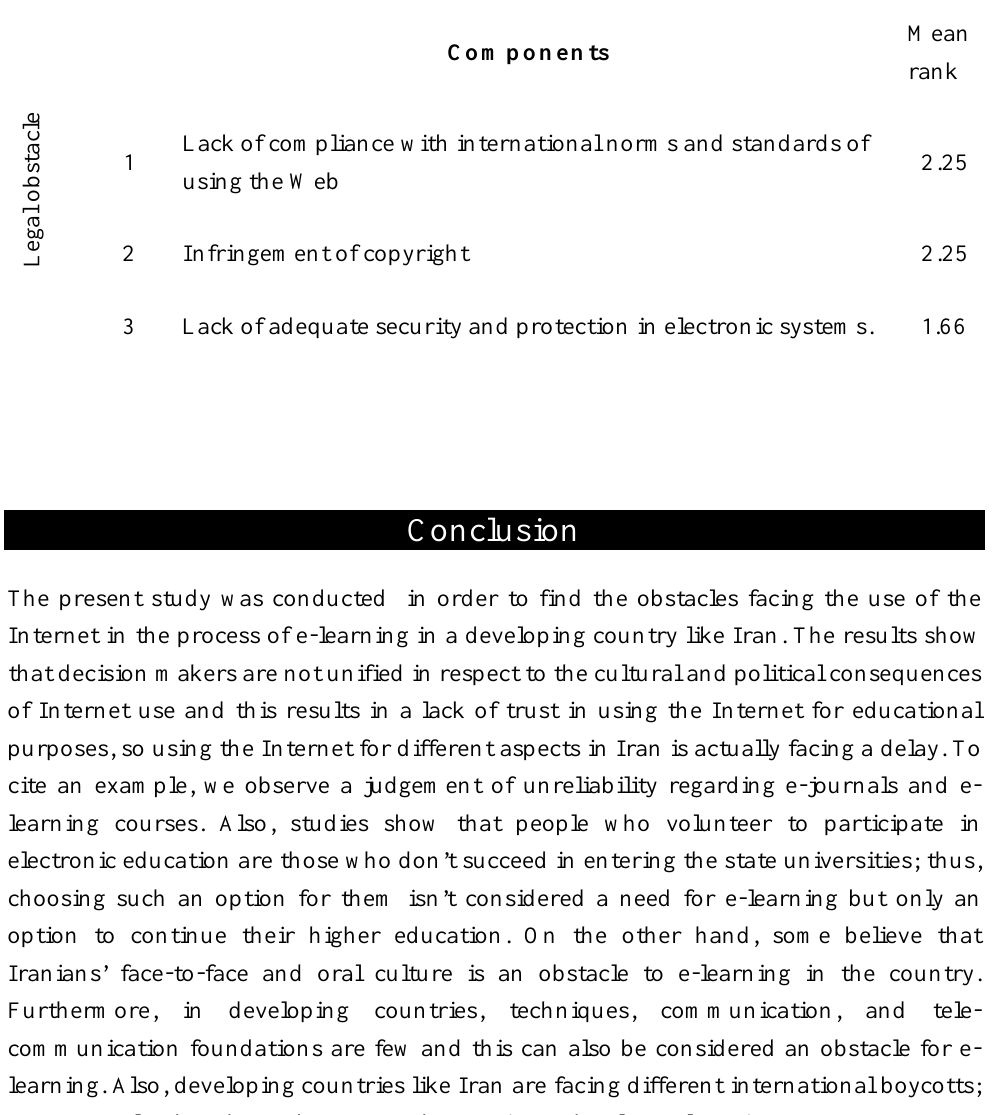
Ranking of the Components within the Legal